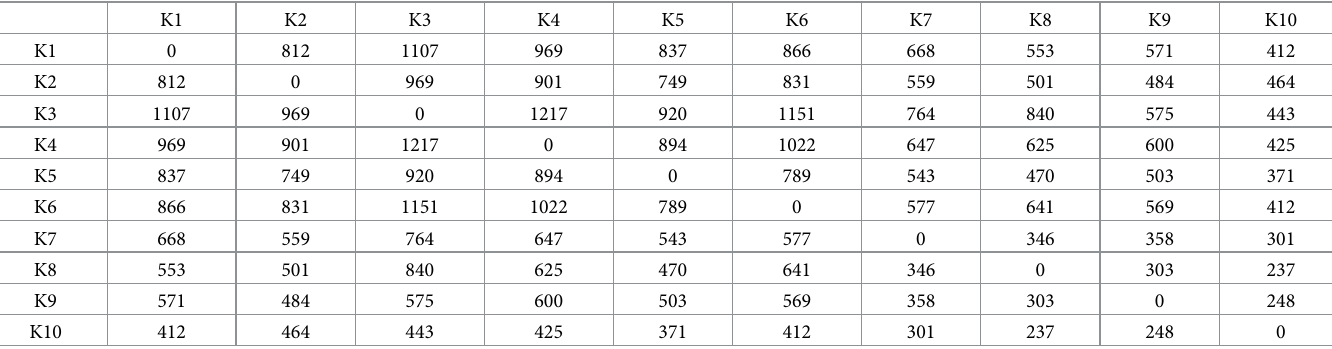
Table 2. The part of co-occurrence matrix based on all